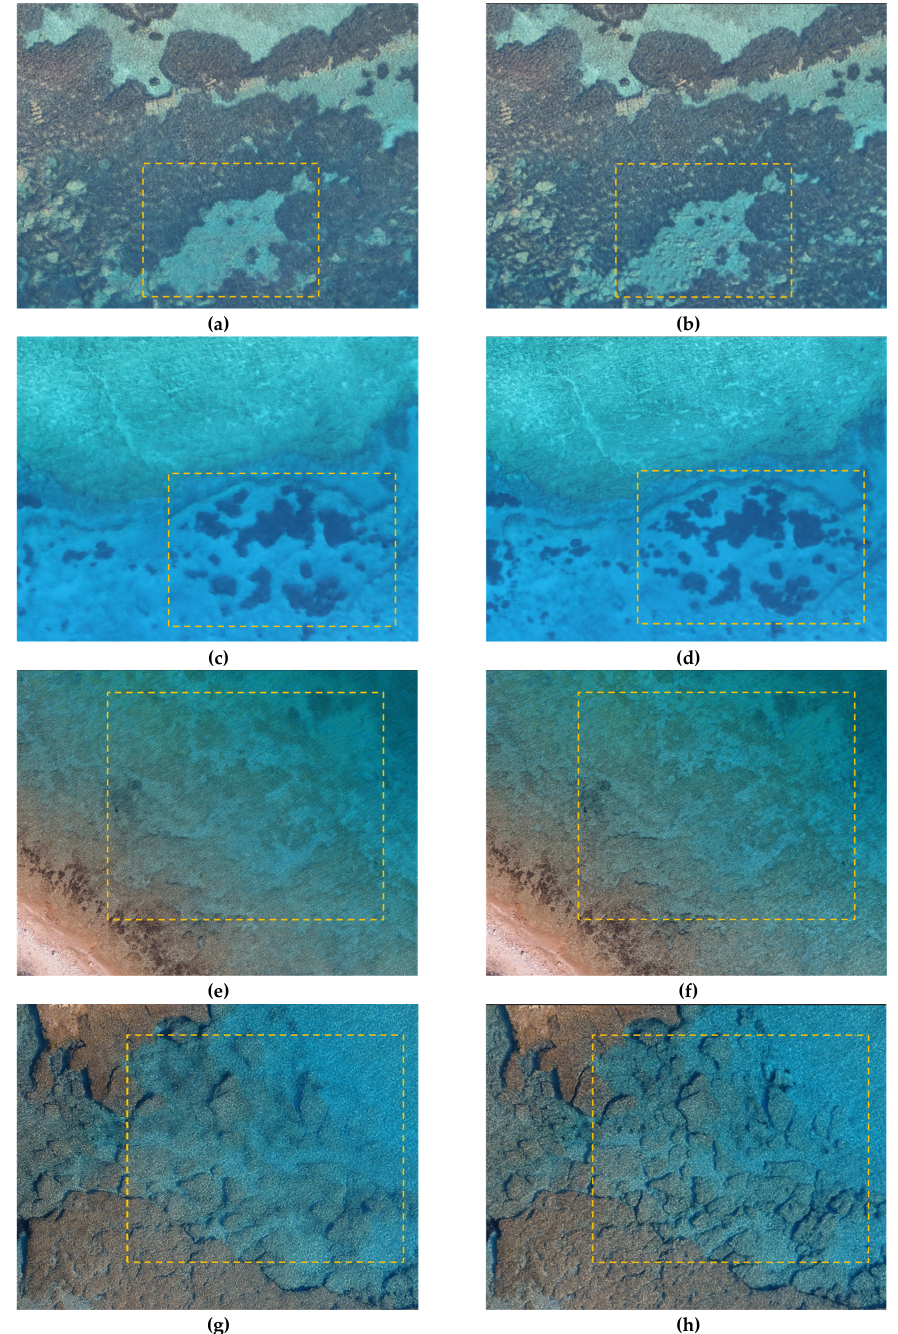
Figure 9. Indicative textured 3D models from Amathounta ( a , b ); Agia Napa ( c , d ); Cyclades-1 ( e , f ); and Cyclades-2 ( g , h ) test sites with the initial uncorrected (left column) and the refraction-free (right column)